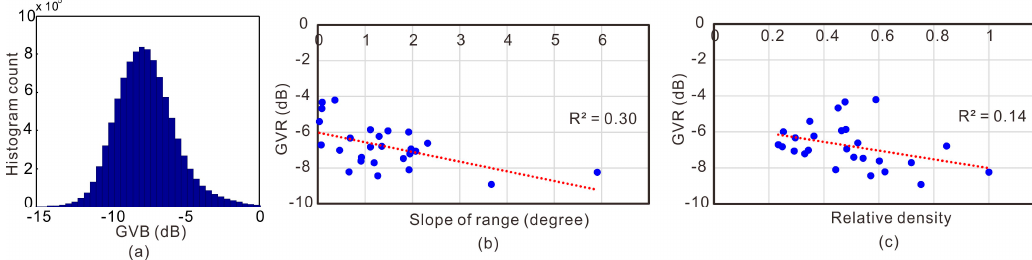
Figure 11. GVR estimates of PD High polarization: ( a ) Histogram of GVR; ( b ) Joint distribution of GVR and slope of range; and ( c ) Joint distribution of GVR and forest density. The red dashed lines in ( b , c ) have been obtained through a line fit between the GVR and the forest density.